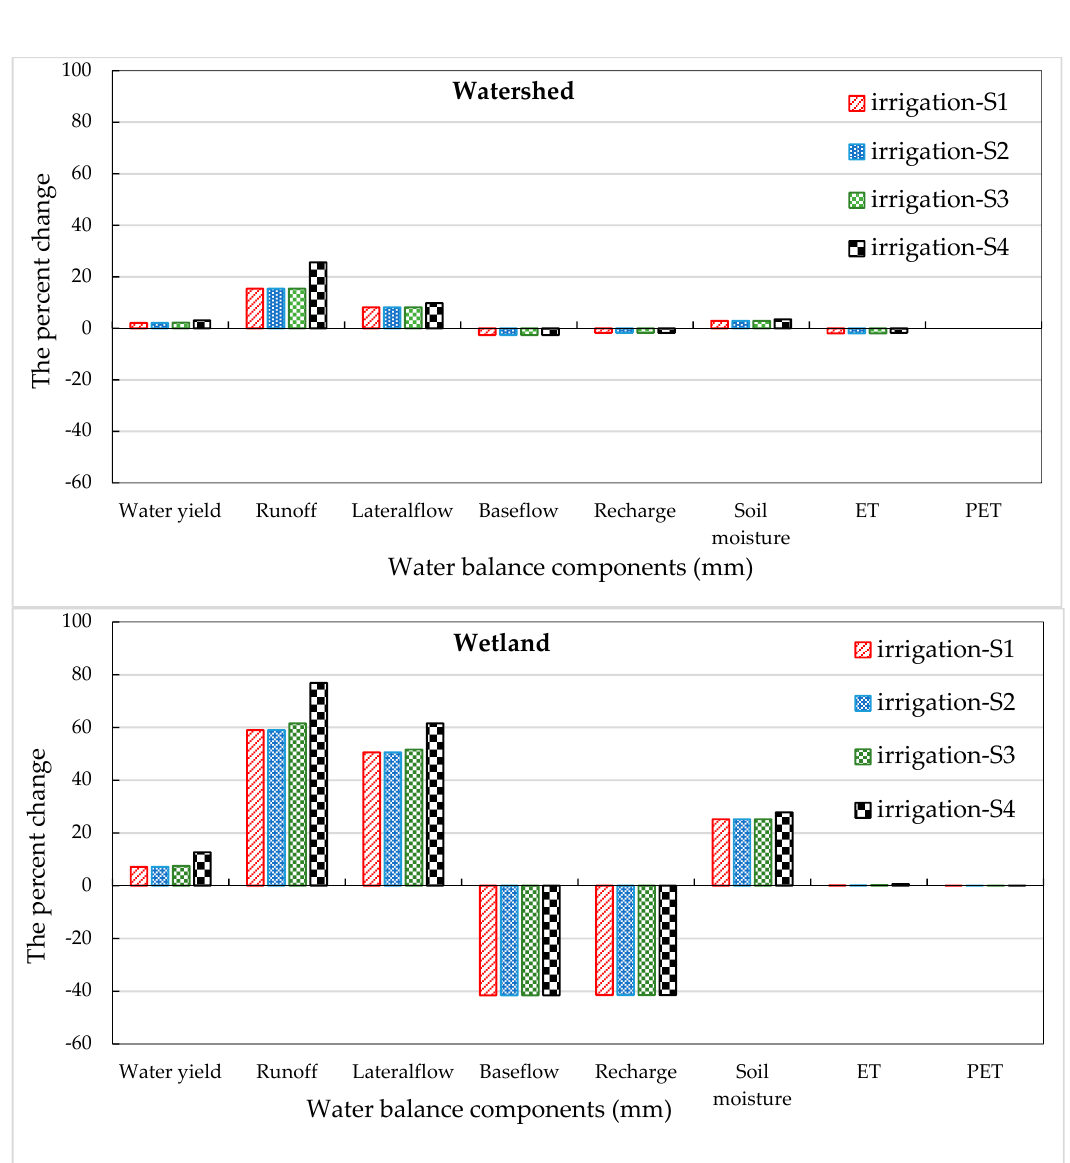
Figure 8. The percent change of yearly average (2002–2014) of WBCs relative to baseline for the Heeia wetland and watershed. S1 = Scenario one (initial minimum streamflow); S2 = Scenario two (decrease 50% of minimum streamflow); S3 = Scenario three (decrease 75% of minimum streamflow); S4 = Scenario four (decrease 90% of minimum streamflow).